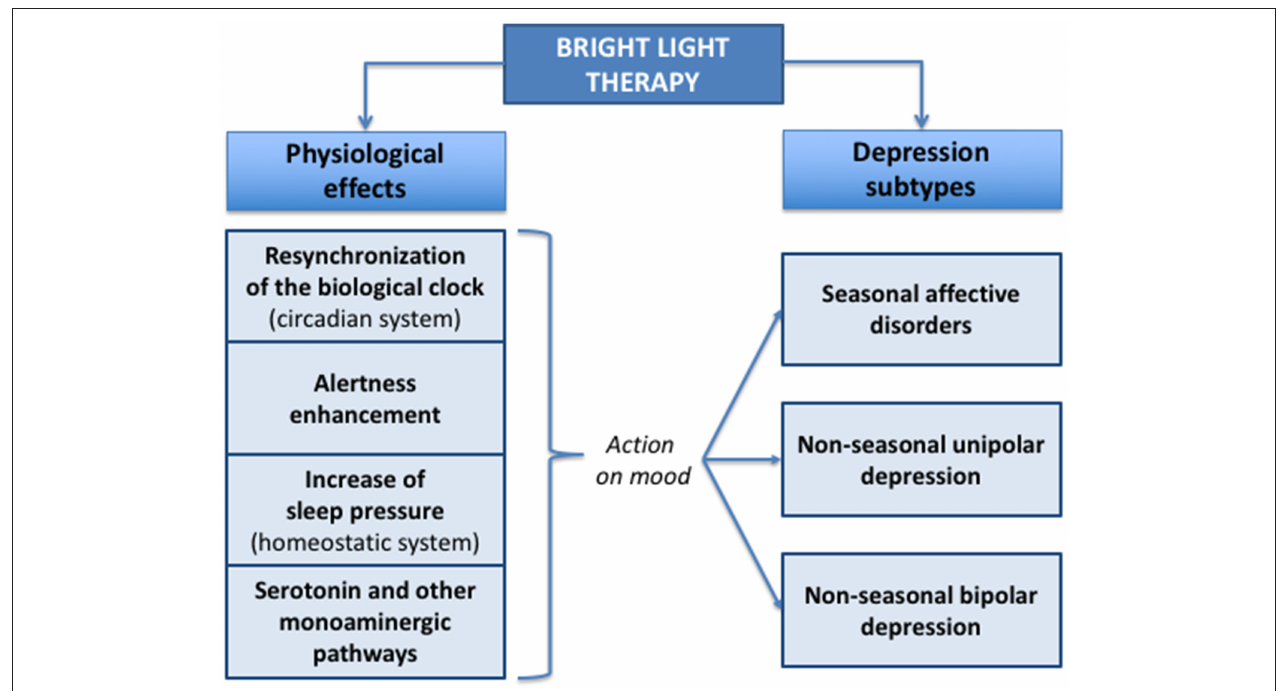
FIGURE 1 | Effects of bright light therapy in mood disorders.